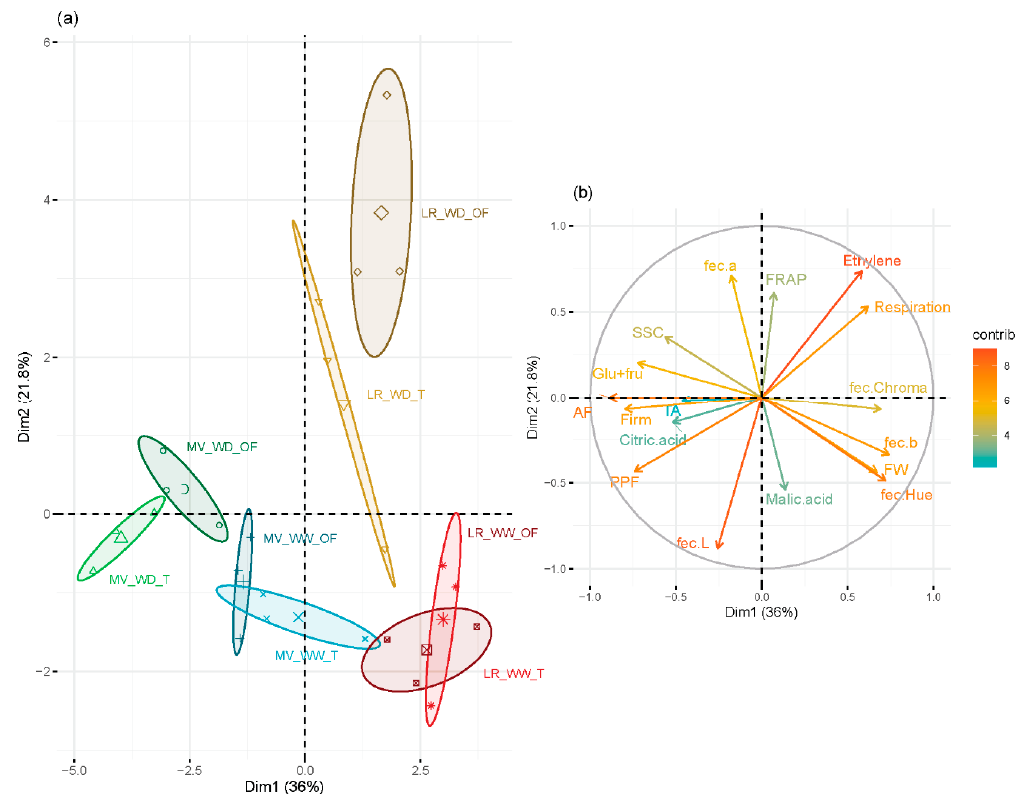
Figure 3. Dissimilarities based on fruit’s physical and chemical traits recorded after 30 days of storage showing the effects of water regime (water deficit, WD; well-watered, WW) and growing environment (open field, OF; tunnel, T) on two Penjar genotypes (landrace, LR; modern cultivar, MV). Scores are represented on the two first principal components (Dim1-Dim2), accounting for 52.8% of the total variation. ( a ) Phenotypic values grouped by treatment (the center of the ellipse is signaled); ( b ) correlation loadings of the variables with the principal components. Abbreviations: ( a ) the abbreviations indicate the genotype (MV/LR), the water regime (WD/WW), and the environment (OF/T); for instance, MV_WD_T indicates: modern variety, water deficit, tunnel; ( b ) FW, fruit weight; AF, acoustic firmness; PPF, peak positive force; Firm, firmness; fec., fruit external color CIELAB coordinates (L, a, b, Chroma, Hue); FRAP, antioxidant capacity; TPC, total phenolic content; SSC, soluble solids content; TA, titratable acidity; IAD, Index of absorbance difference; Glu + fru, glucose + fructose content.